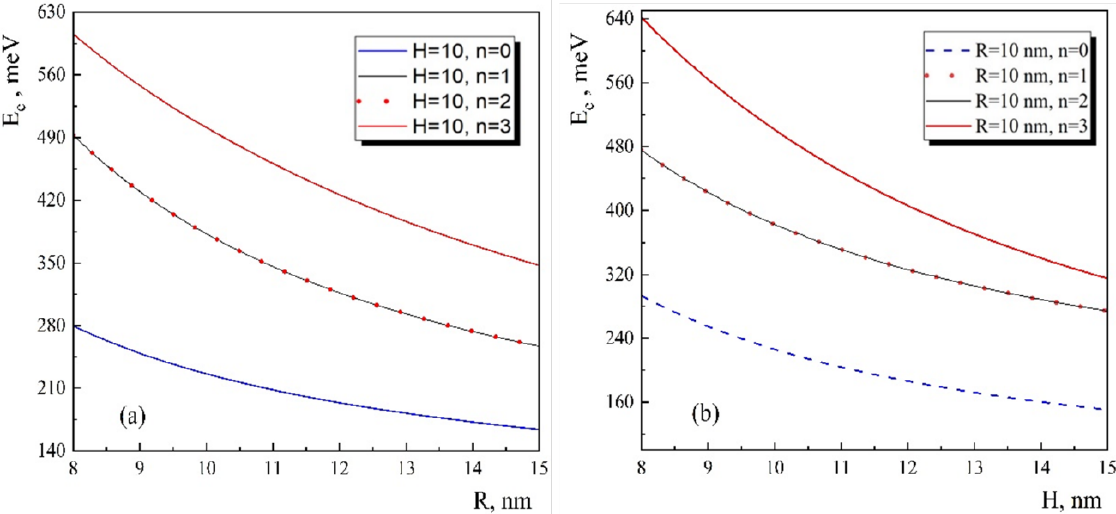
Figure 3. The dependences of the electron energy on the ( a ) radius of the conical QD and ( b ) height of the conical QD for the first four levels.